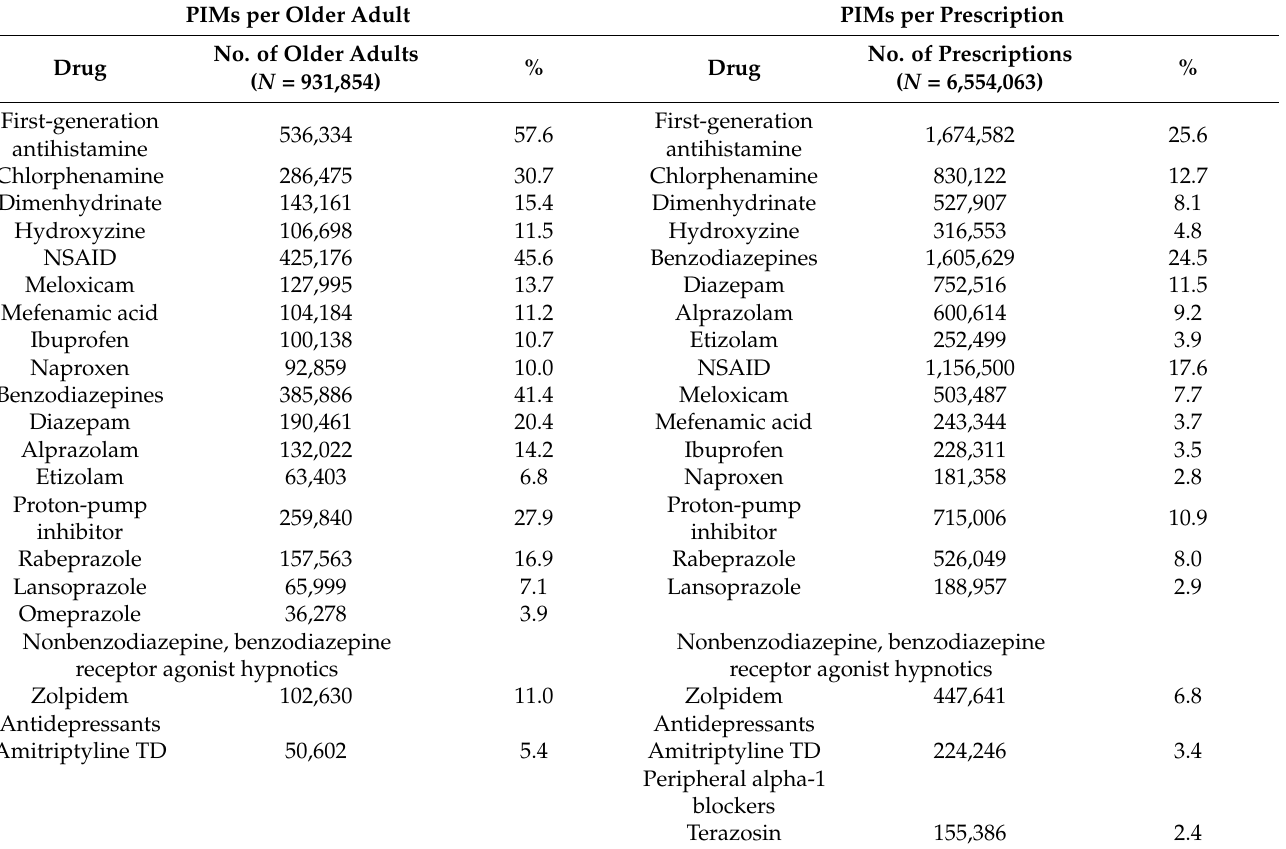
Table 2. Top 15 prescribed drugs in potentially inappropriate medications .